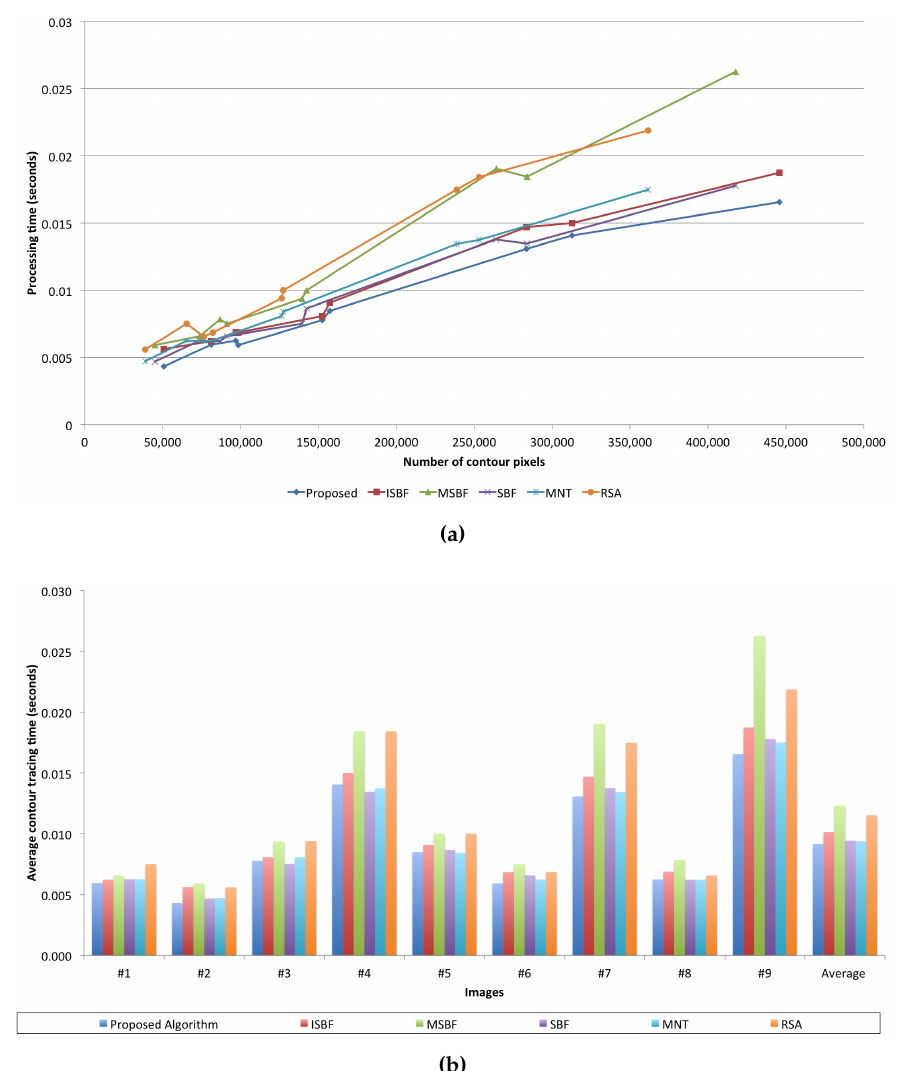
Figure 18. Comparison of tracing times of the contour-tracing algorithms. ( a ) Processing time vs. the number of contour pixels; ( b ) average contour tracing time vs.